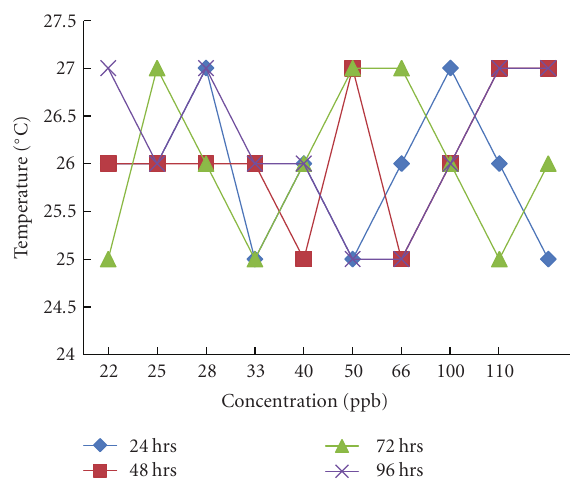
Figure 3: Temperature of test solution during 96-hour exposure of Clarias gariepinus of various concentrations of gammalin 20.